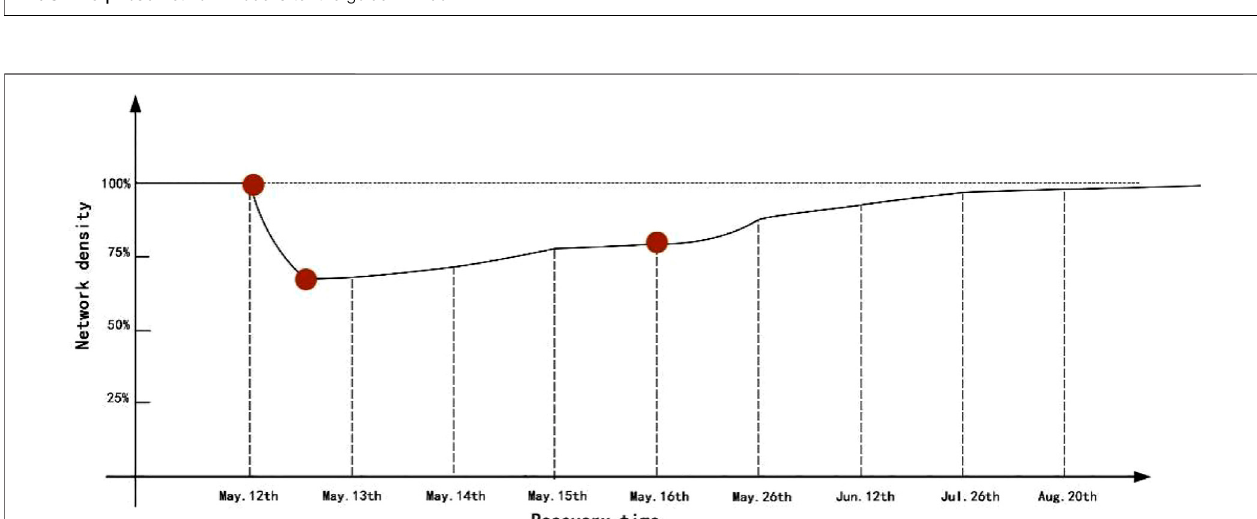
FIGURE 9 | Road network model after the golden window.